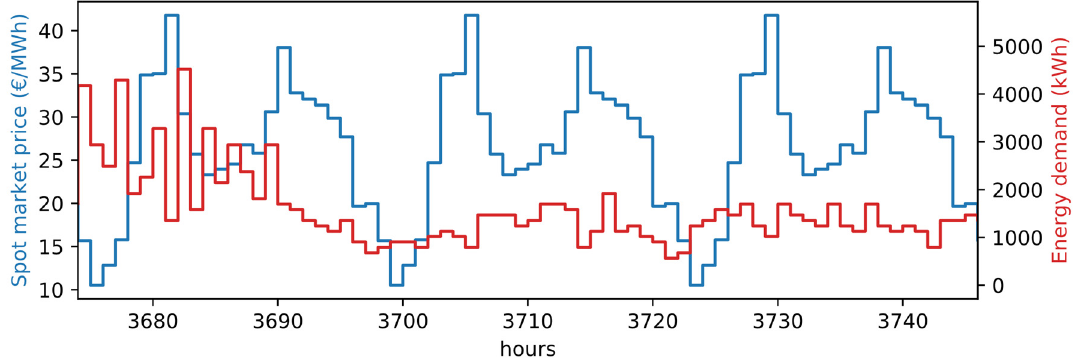
Figure 13. Cutout of the electricity price and demand profiles for Case 2.